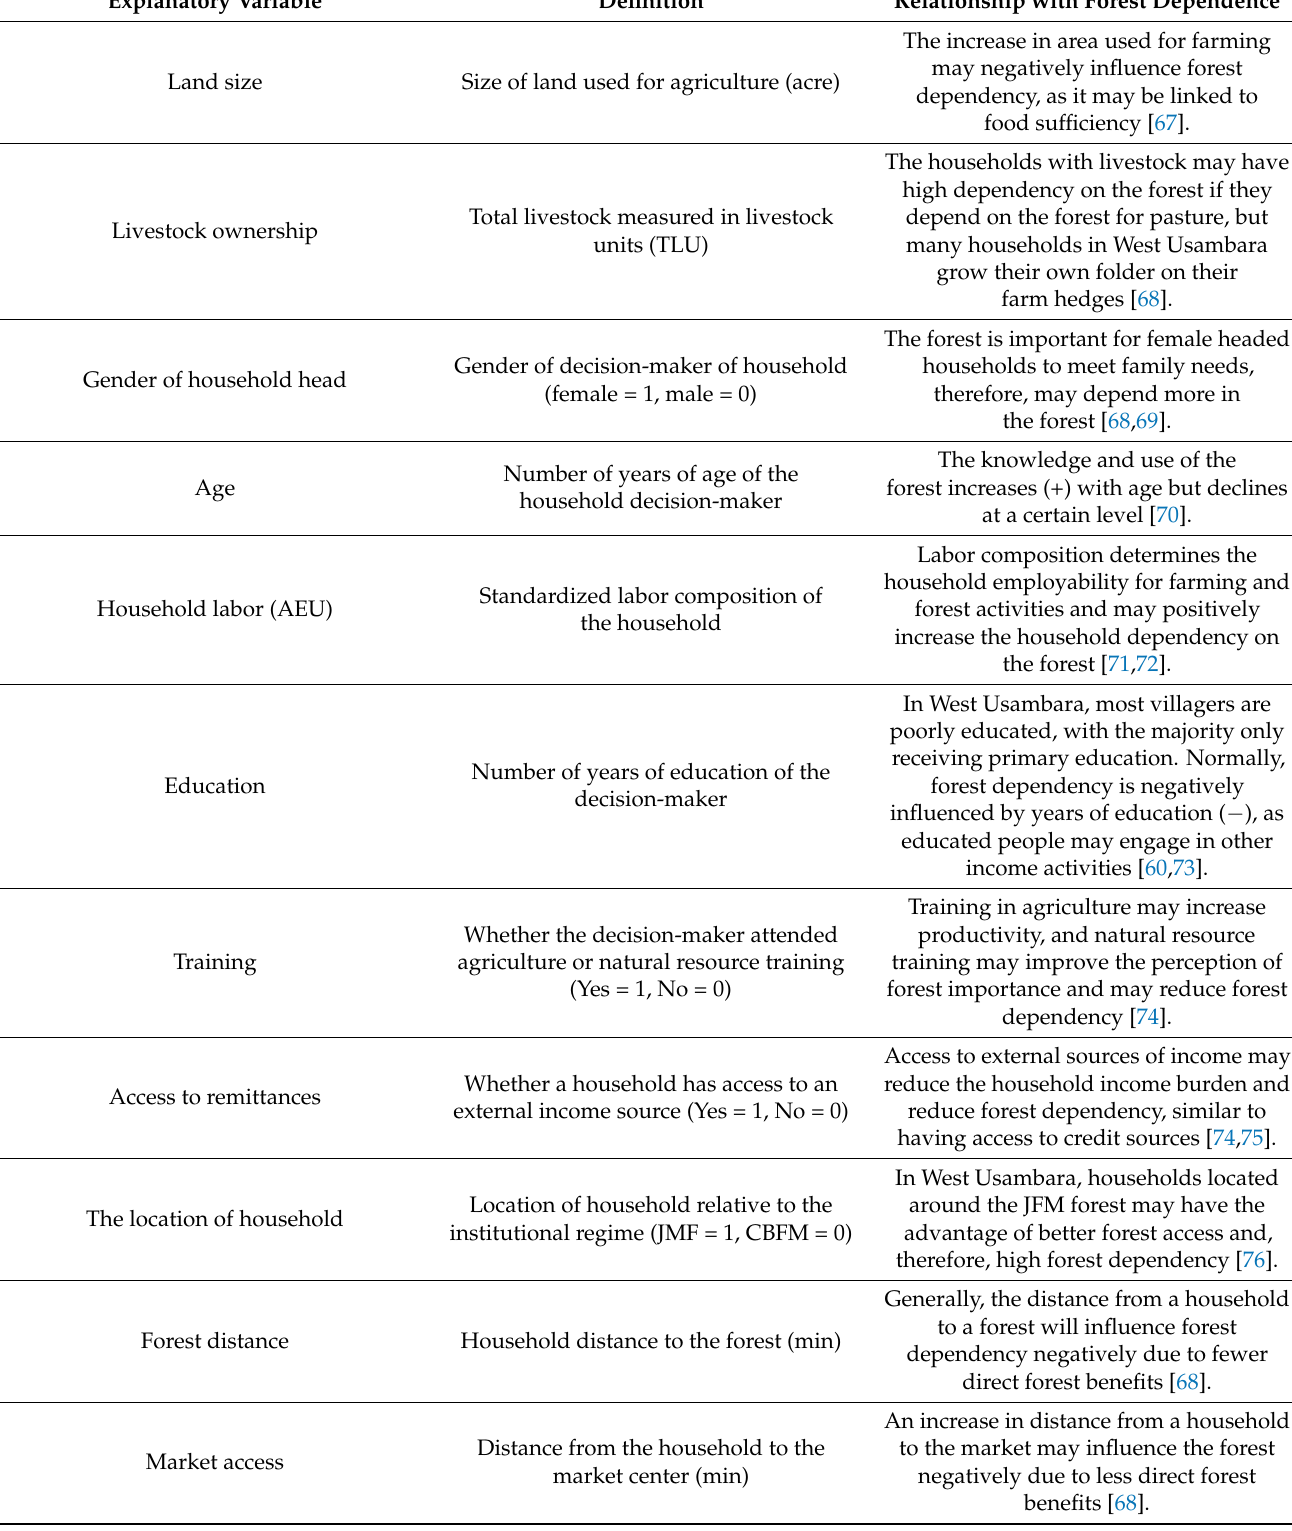
Table 1. Hypothesized determinants of livelihood strategies and forest